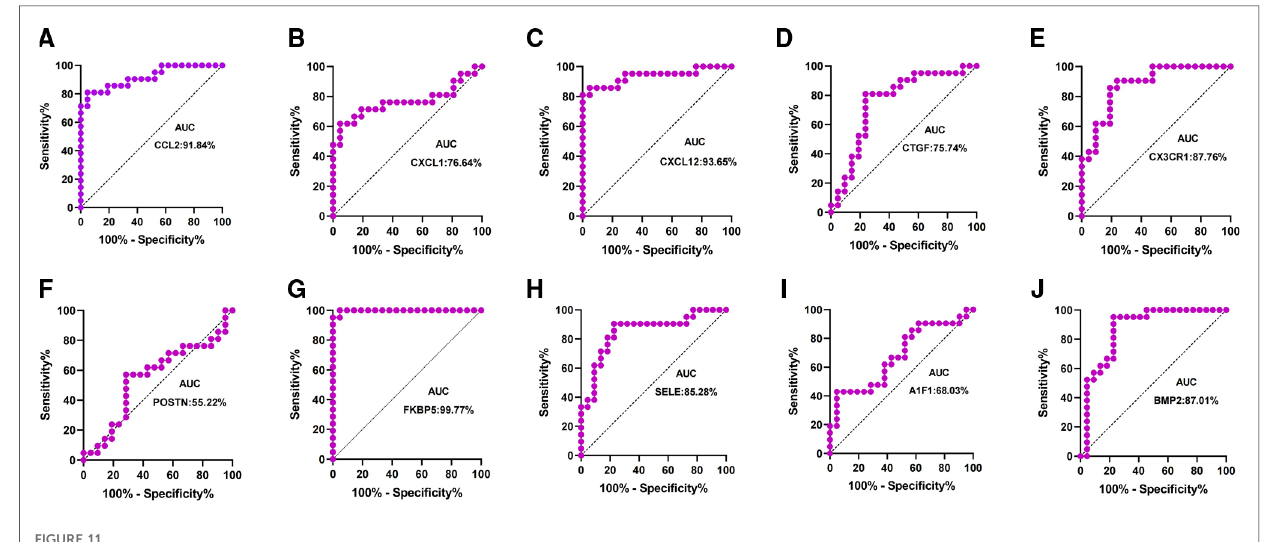
FIGURE 11 ( A – J ) ROC curves for top 10 hub genes,